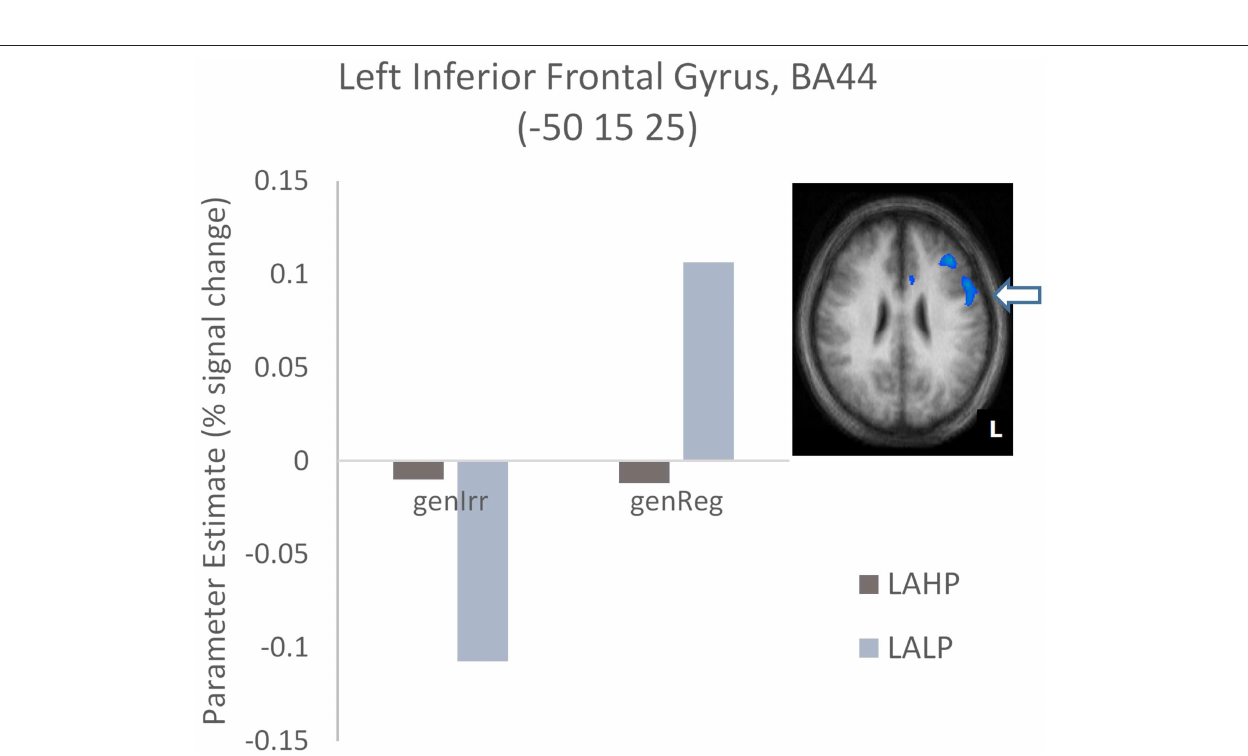
FIGURE 4 | Activation differences in BA44 between the high proficiency (LAHP) and low proficiency (LALP) late bilinguals in the Regular × Proficiency condition. Activated regions are those activated above the indicated threshold ( p < 0.05, corrected).